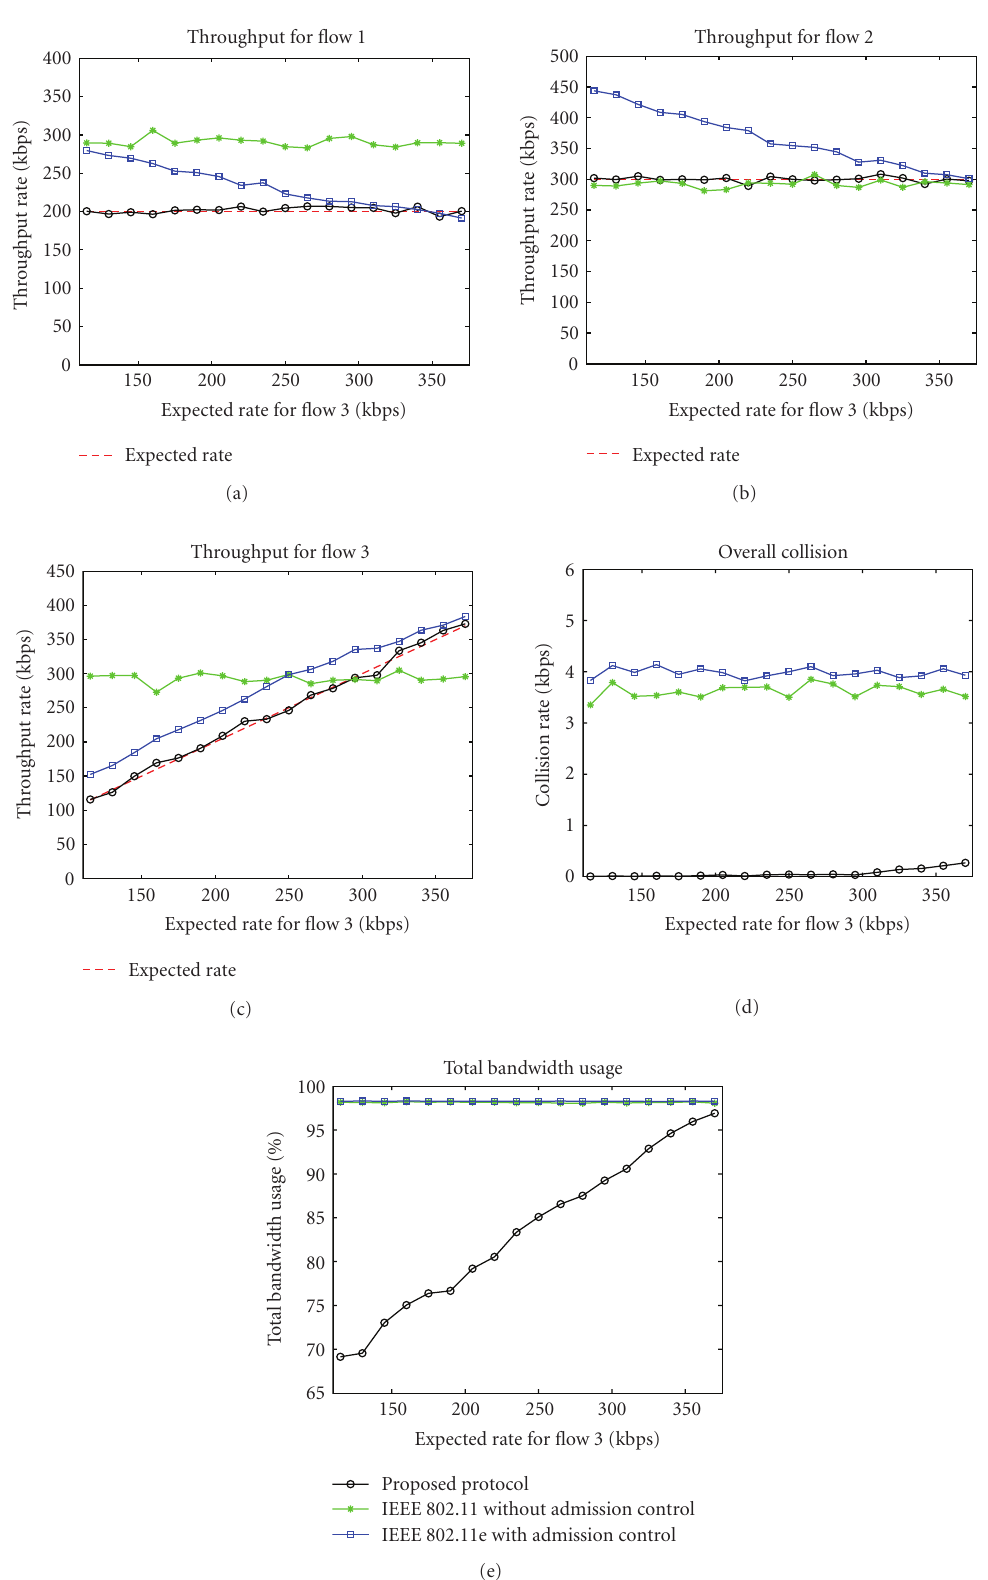
Figure 2: Performance comparisons for the proposed protocol versus IEEE 802.11 and IEEE 802.11e protocols. (a) Throughput for flow 1, (b) throughput for flow 2, (c) throughput for flow 3, (d) overall collision, and (e) overall bandwidth